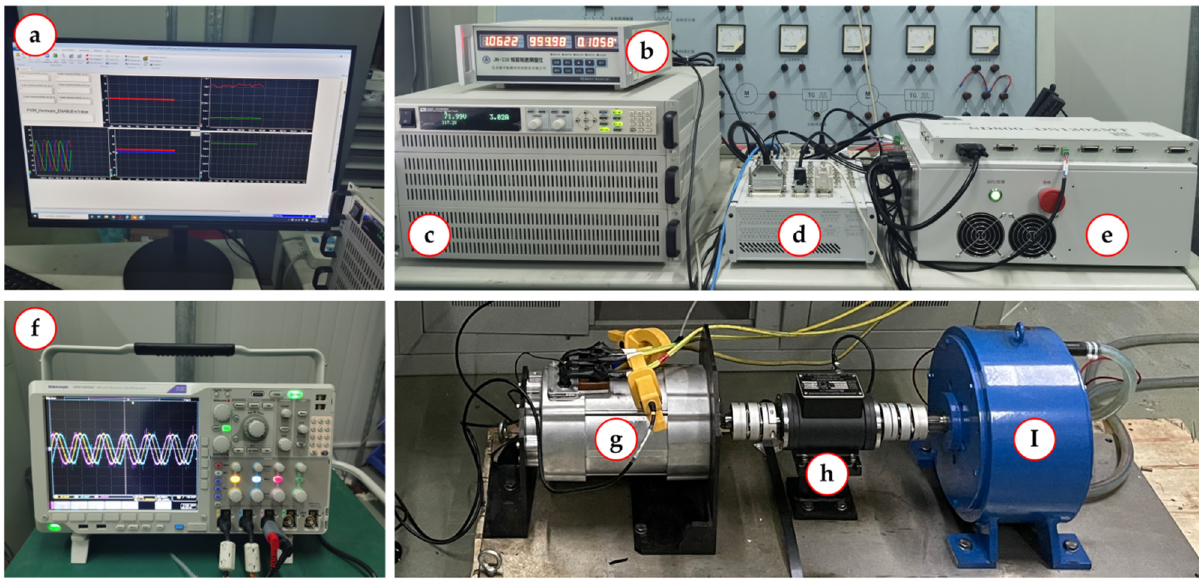
Figure 8. Experimental platform of the SynRM prototype: ( a ) PC with dSPACE ControlDesk software, ( b ) torquemeter, ( c ) 9 kW DC power supply, ( d ) MicroLabBox dSPACE ds1202, ( e ) customized three-phase inverter, ( f ) oscilloscope, ( g ) 2 kW SynRM prototype with a resolver, ( h ) torque sensor, and ( i ) hysteresis brake.